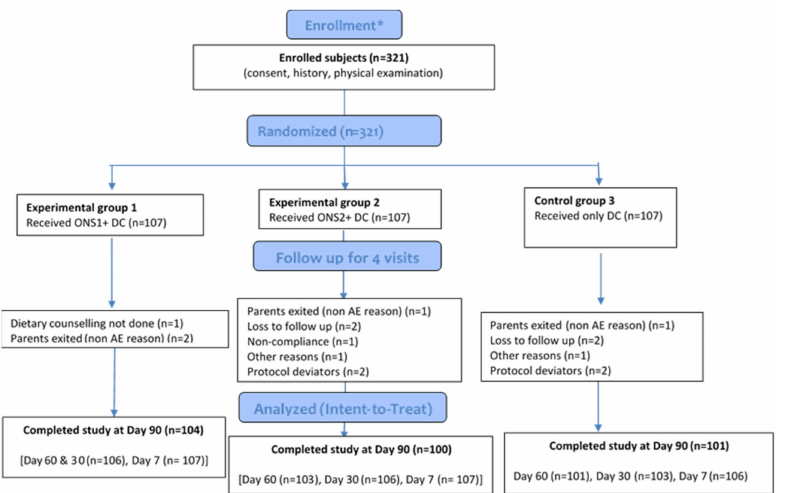
Figure 1. CONSORT 2010 flow diagram * Enrollment and randomization was at baseline/visit 1. Baseline and demographic characteristics were reported for all randomized subjects. (ONS: Oral Nutritional Supplement; DC: Dietary Counseling; AE: Adverse